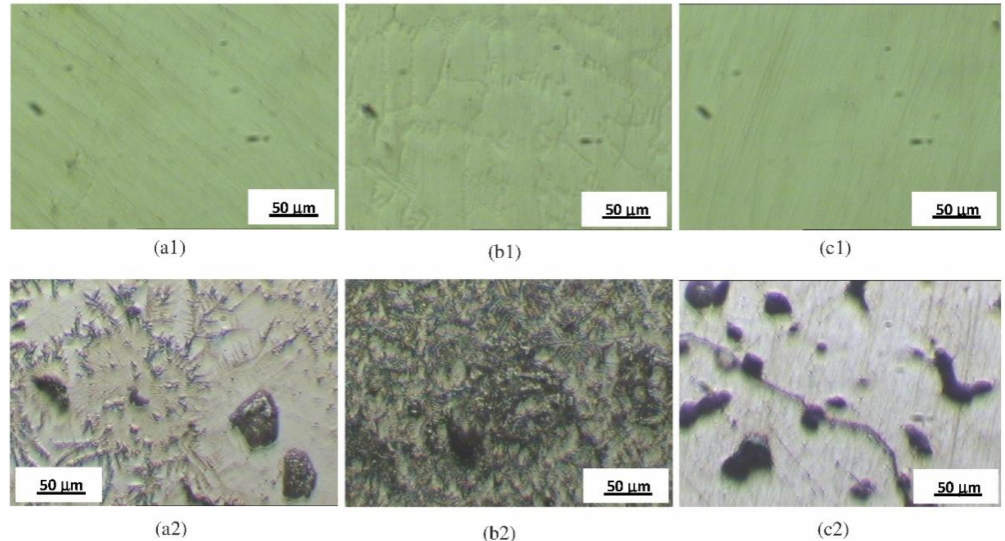
Figure 3. Microstructures before electrochemical treatments for ( a1 ) specimen Ni5, ( b1 ) specimen Ni4, ( c1 ) specimen Ni6; after electrochemical treatments for ( a2 ) specimen Ni5, ( b2 ) specimen Ni4, and ( c2 ) specimen Ni6.